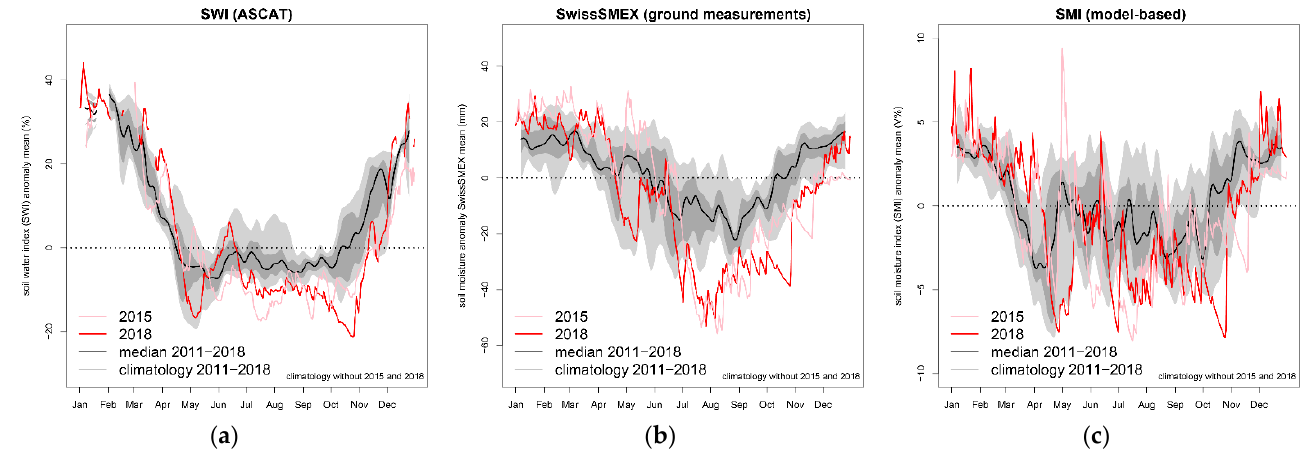
Figure 4. Seasonal evolution of daily soil moisture anomalies (anomalies w.r.t. the long-term mean), averaged over the considered grassland stations, for ( a ) the satellite-based ASCAT soil water index (SWI), ( b ) the station-based SwissSMEX soil moisture measurements, and ( c ) the modelled soil moisture index (SMI). The background climatology in grey and black is based on the years of 2011 to 2018 (without the dry years of 2015 and 2018). The dark grey shading shows the 25% – 75% range of the respective background climatology; the light grey shading shows the 5 – 95% range. The evolution of the respective median as well as of the covered dry years is highlighted.